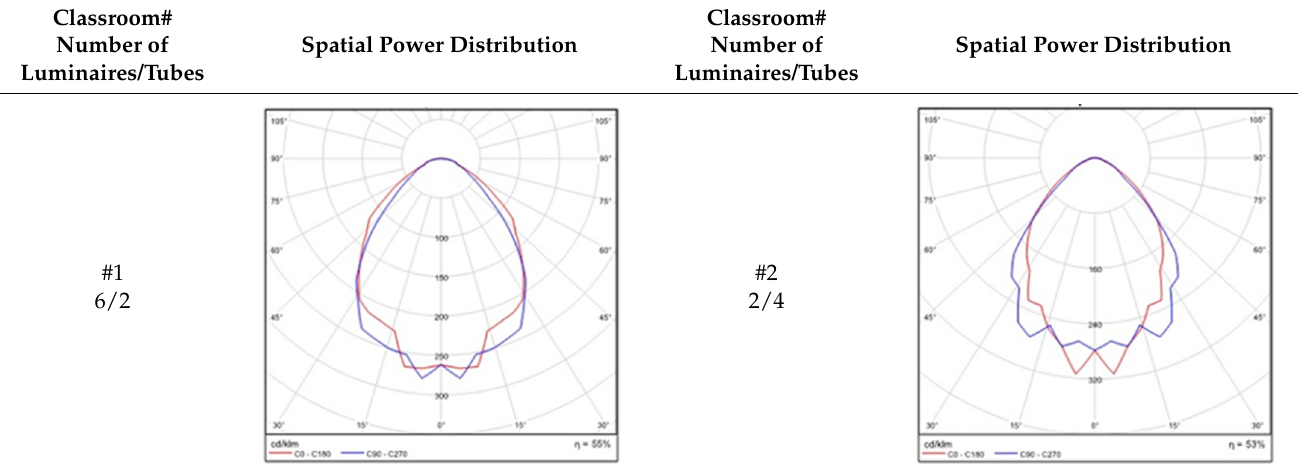
Table 1. Number of luminaires, number of fluorescent tubes and characteristics of the luminaires selected in DialuxEvo of each one by classroom.